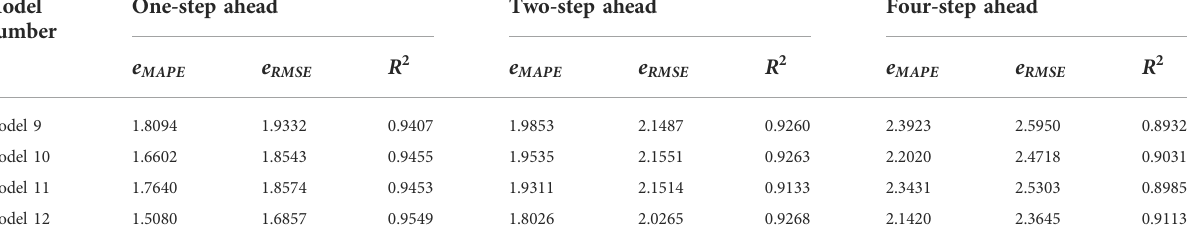
TABLE 10 Prediction results of the model combined with quadratic decomposition technique (Case